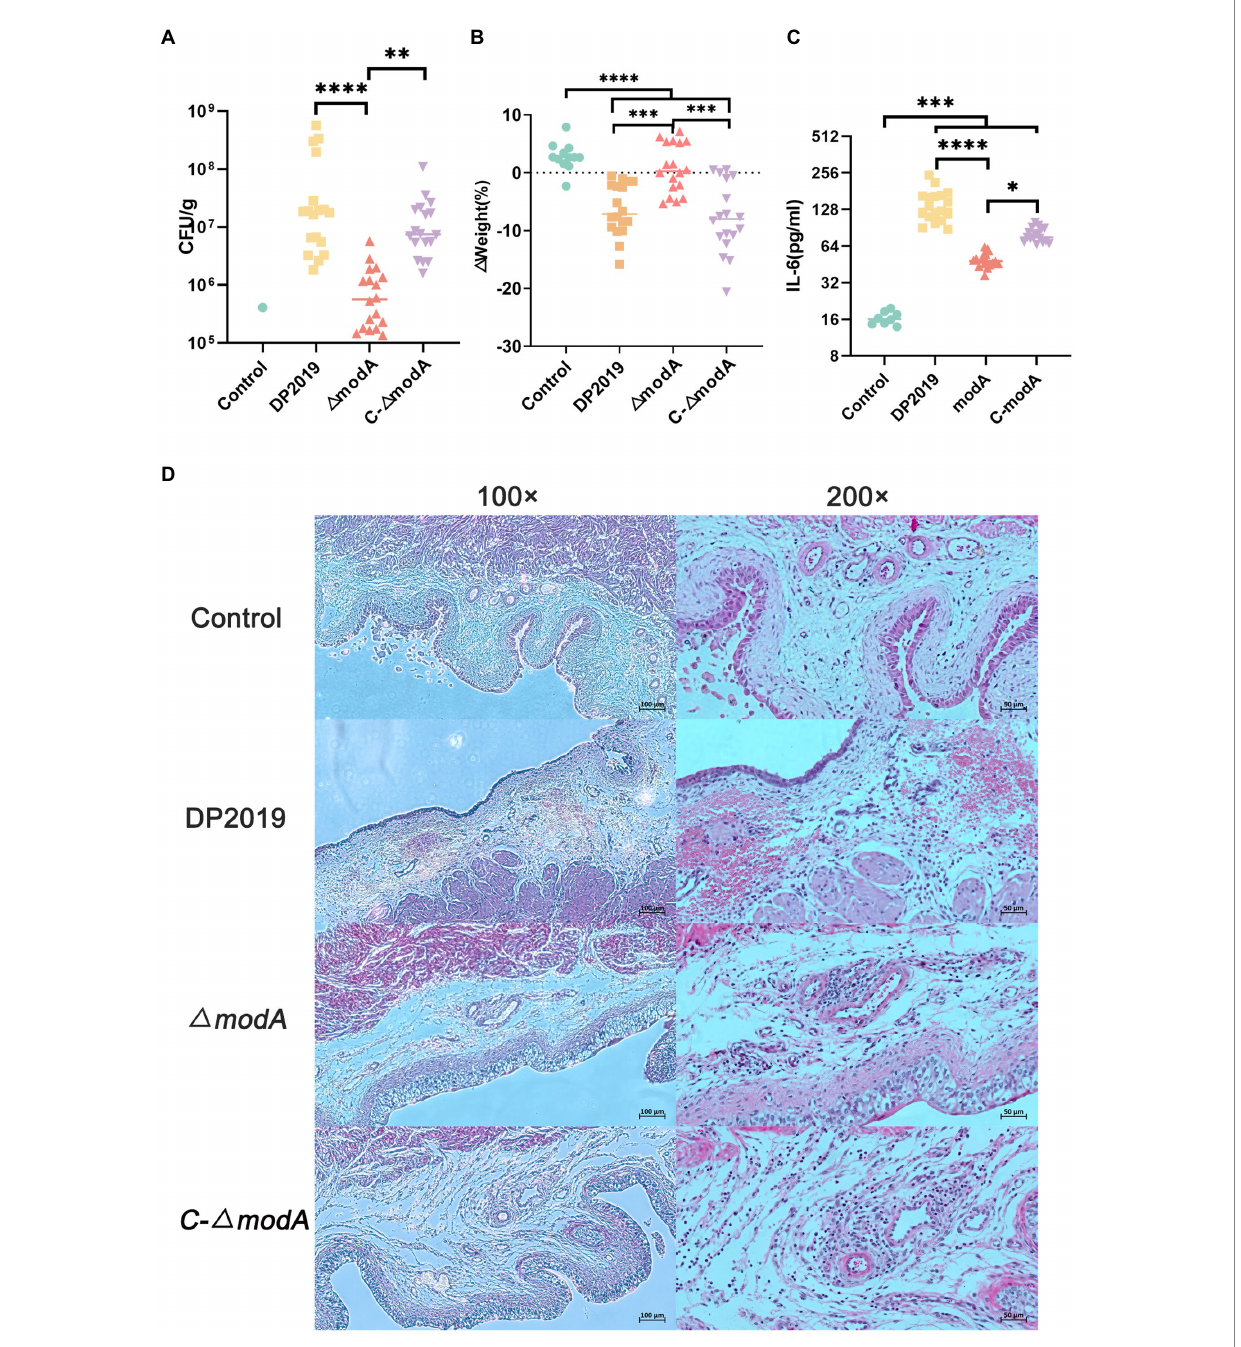
FIGURE 6 Mouse UTI infection model. (A) Levels of bacterial colonization in bladder tissue. Each square triangle represents CFU per gram of bladder tissue from an individual mouse. Horizontal lines represent the geometric means of the colony counts, n = 12 for the Control group, n = 18 for each UTI group. ** p < 0.01, **** p < 0.0001. (B) Changes in mouse body weight before and after infection, it was represented as % from the original weight rather than absolute values, n = 12 for the Control group, n = 18 for each UTI group, *** p < 0.001, **** p < 0.0001. (C) IL-6 levels in the bladders of the mice, we